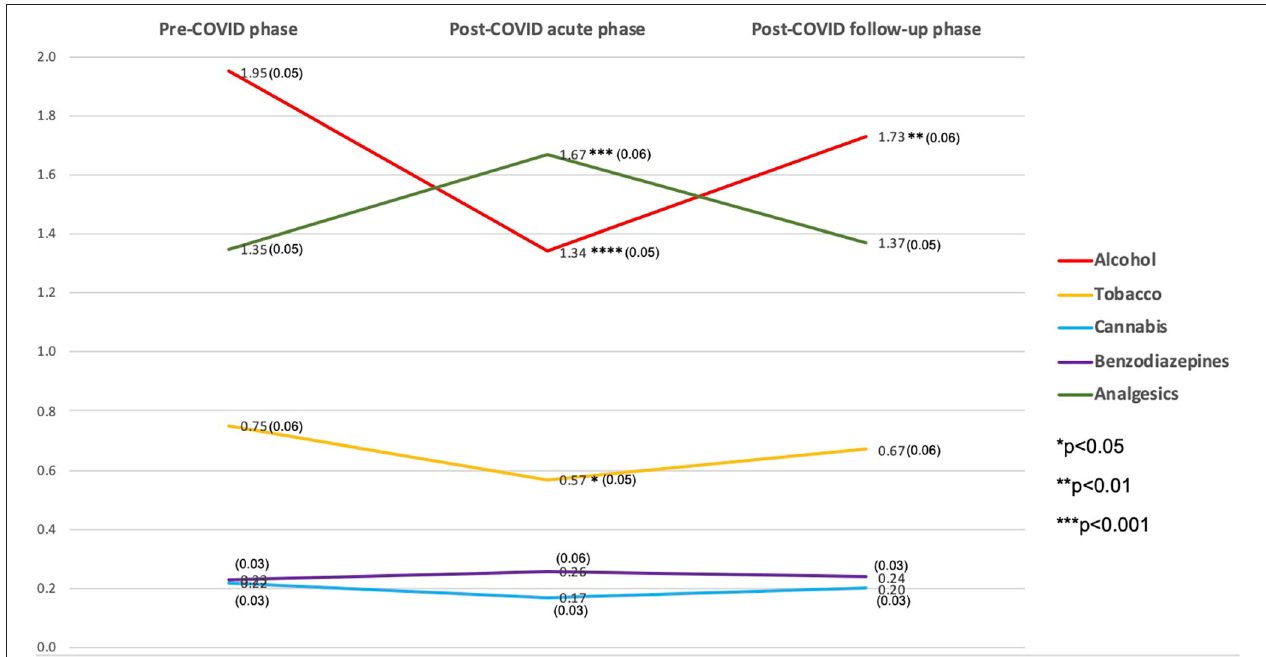
FIGURE 1 | Last-month substance use frequency ASSIST score among 993 individuals who had mild COVID-19 in São Caetano do Sul, SP, Brazil, 2020 (y-axis = ASSIST frequency mean score).